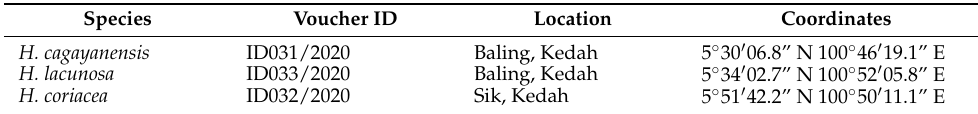
Table 1. List of flower species, vouchers, and collection locality.